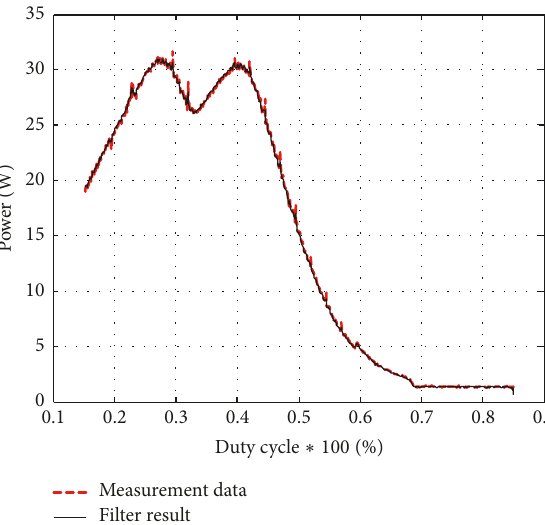
Figure 12: D - P characteristics after least square of PV.